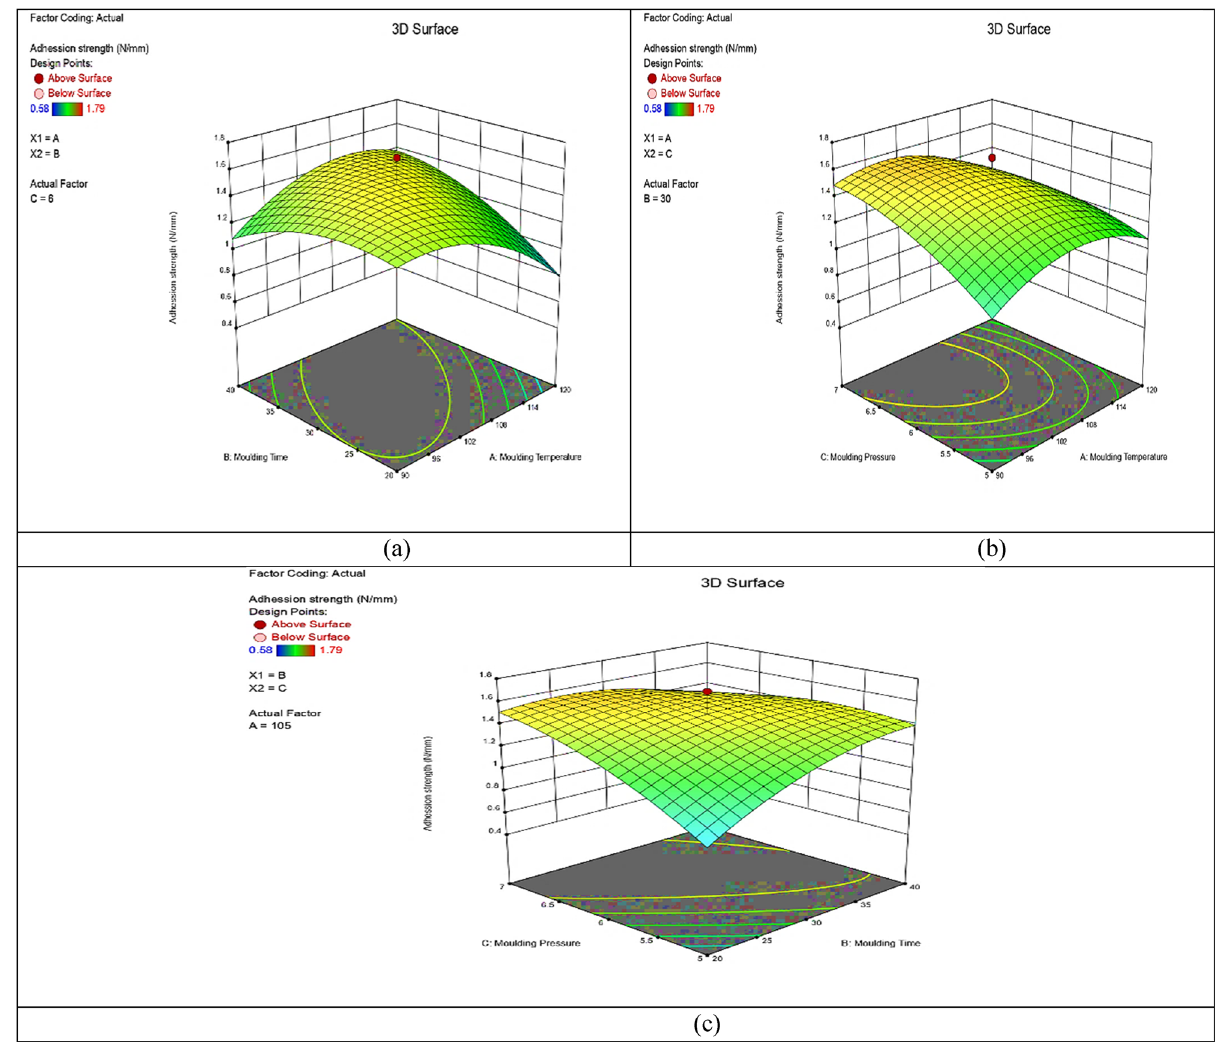
Figure 28: ( a – c ) 3D interaction plots for adhesion strength of leather bu ffi ng dust reinforced recycled EVA polymer composites.